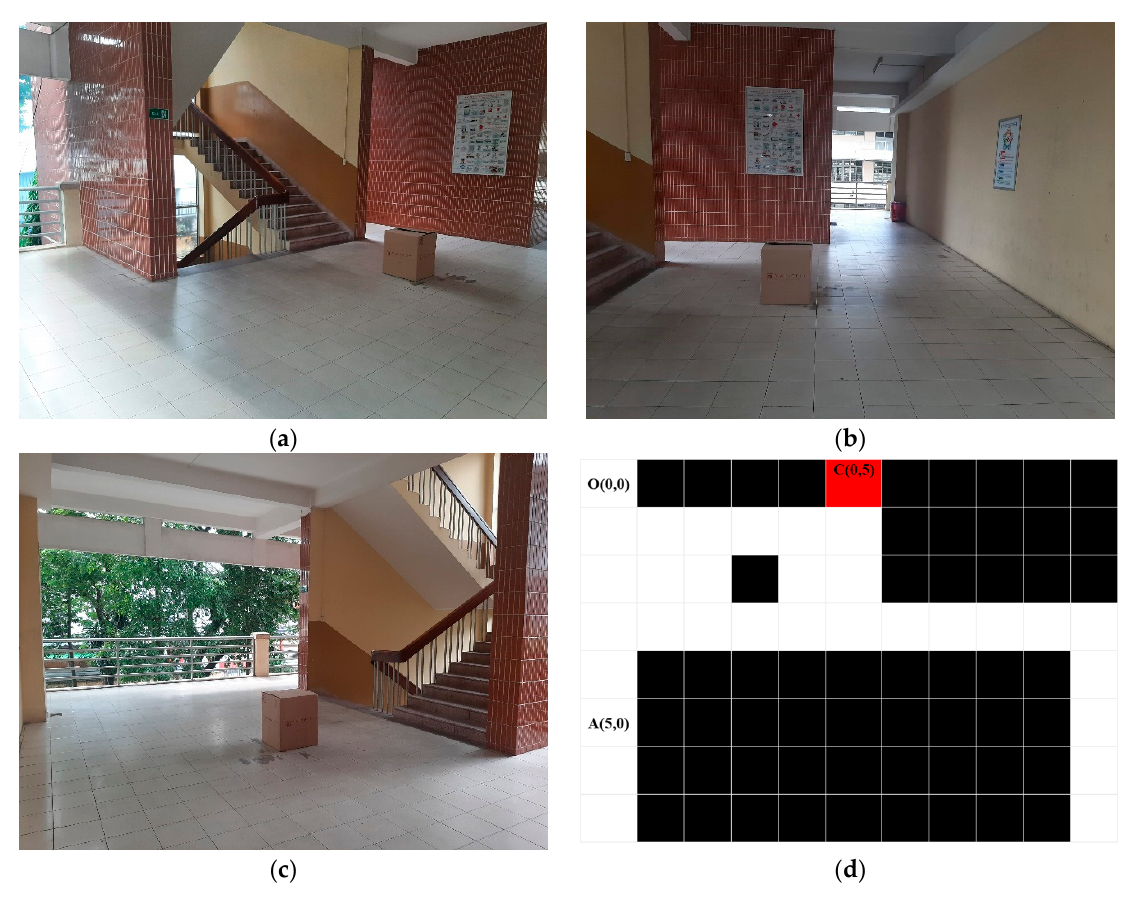
Figure 11. The experimental environment. ( a ) The 1st view of the real environment; ( b ) the 2nd view of the real environment; ( c ) the 3rd view of the real environment; ( d ) the 2D grid map.